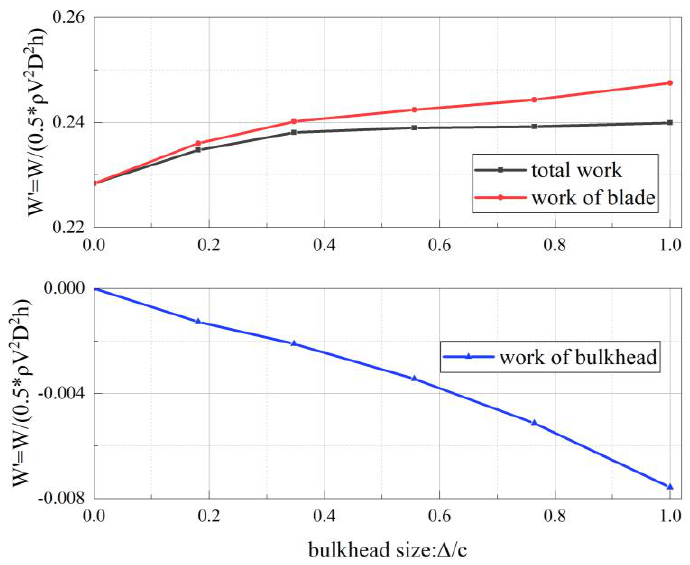
Figure 18. Total work, blade work, and bulkhead work under six sizes of bulkhead.